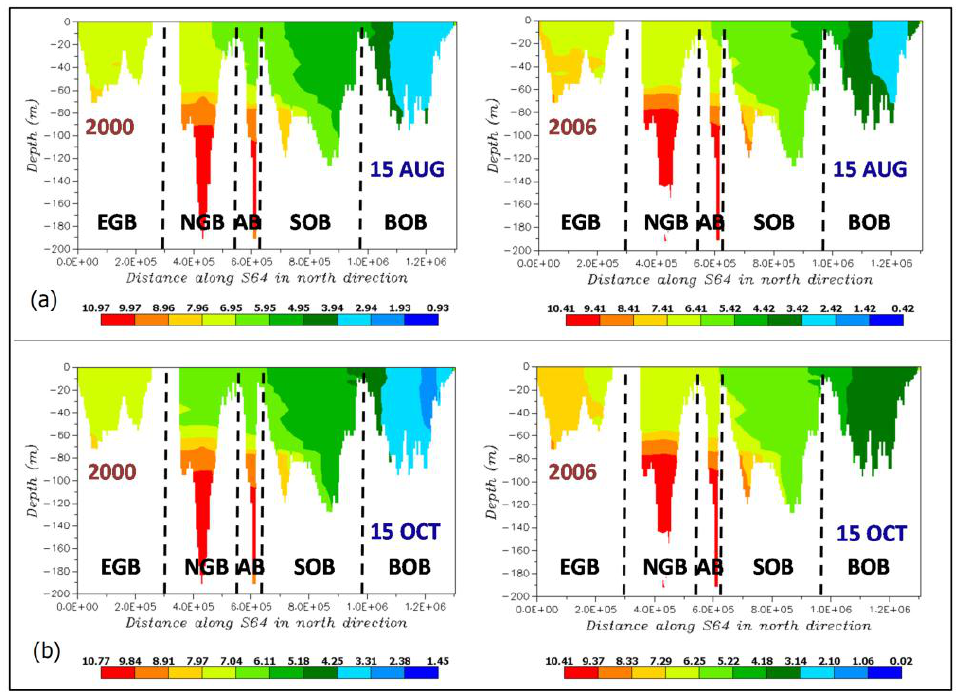
Figure 18. ( a ) Summer salinity stratification in the Baltic Sea at cross section S64 for the years 2000 and 2006; ( b ) Autumn salinity stratification in the Baltic Sea at cross section S64 for the years 2000 and 2006.